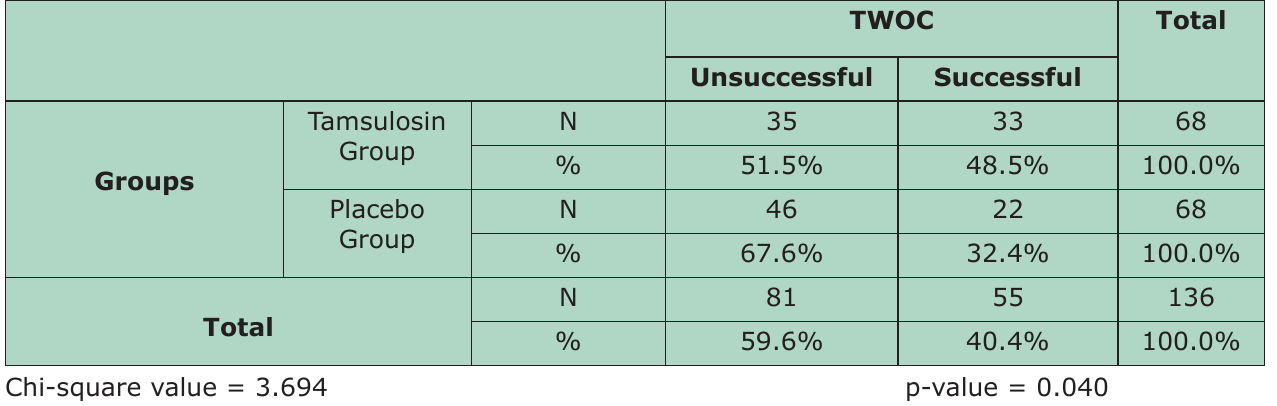
Table-II: Cross tabulation among group and TWOC.